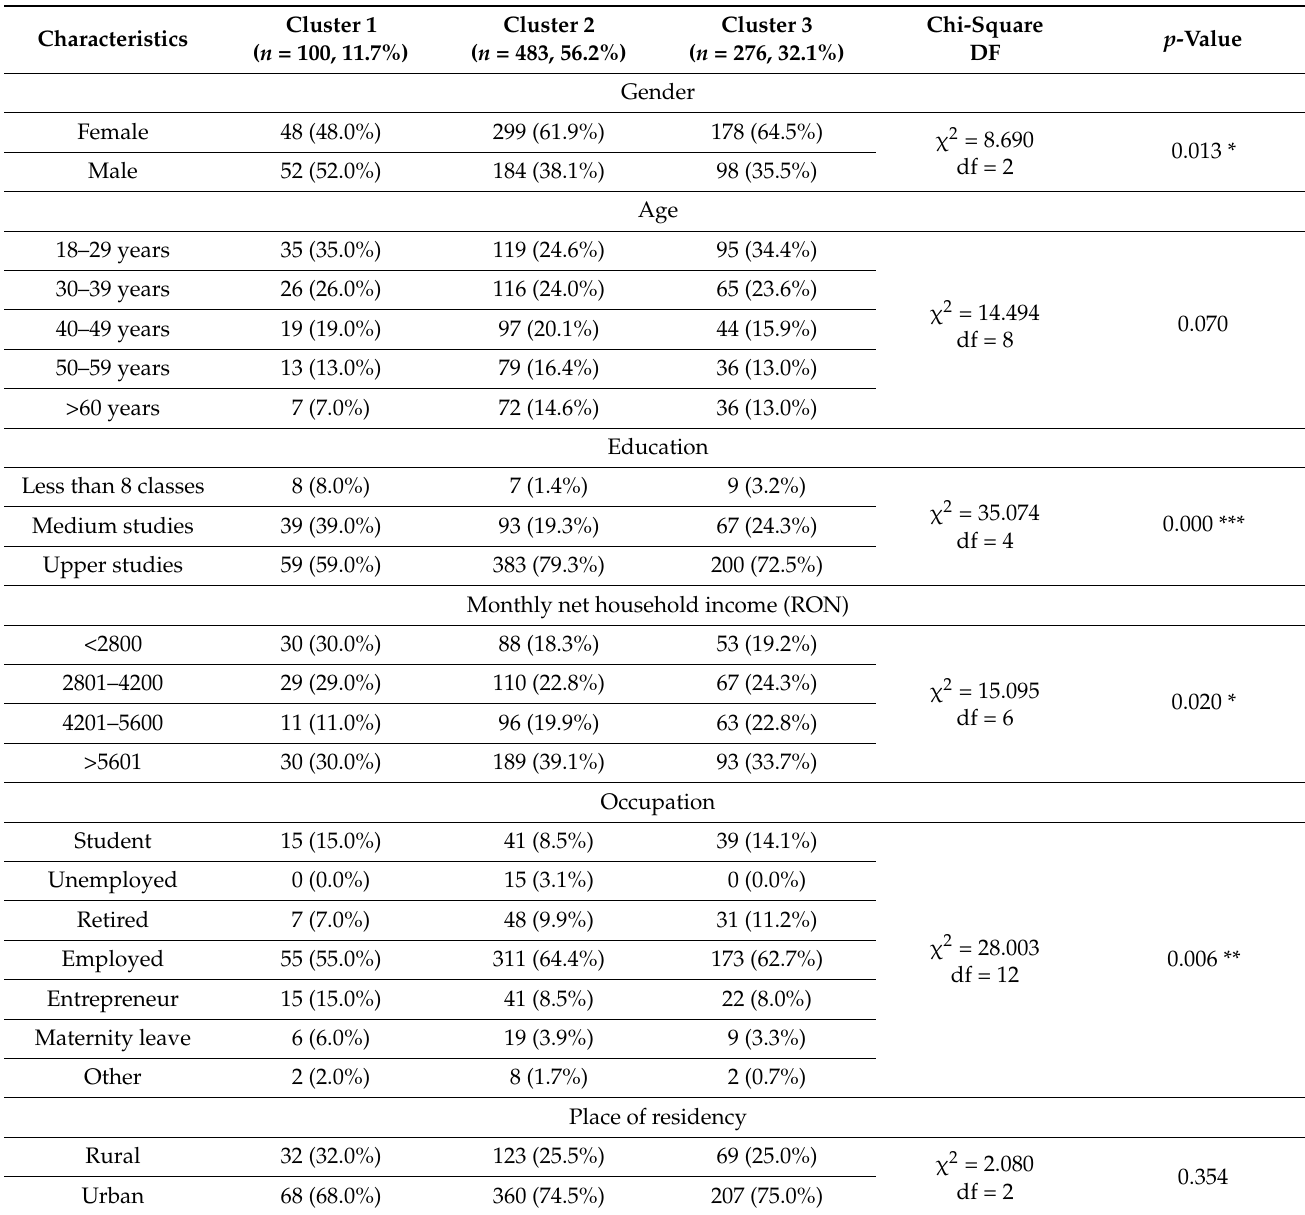
Table 5. Clusters socio-demographic